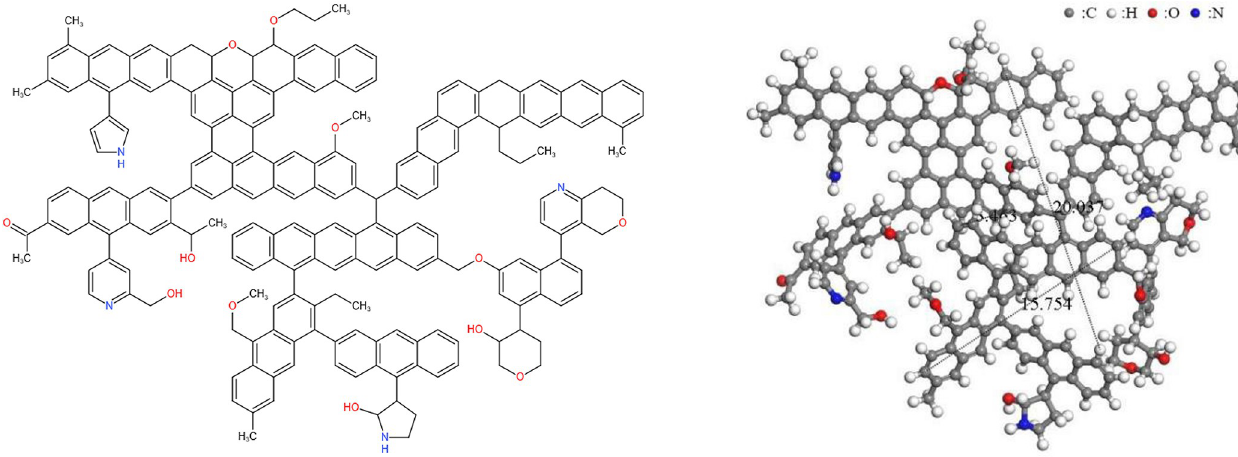
Fig 11. Molecular model of anthracite coal. (a) 2D structure, (b) 3D optimized structure.